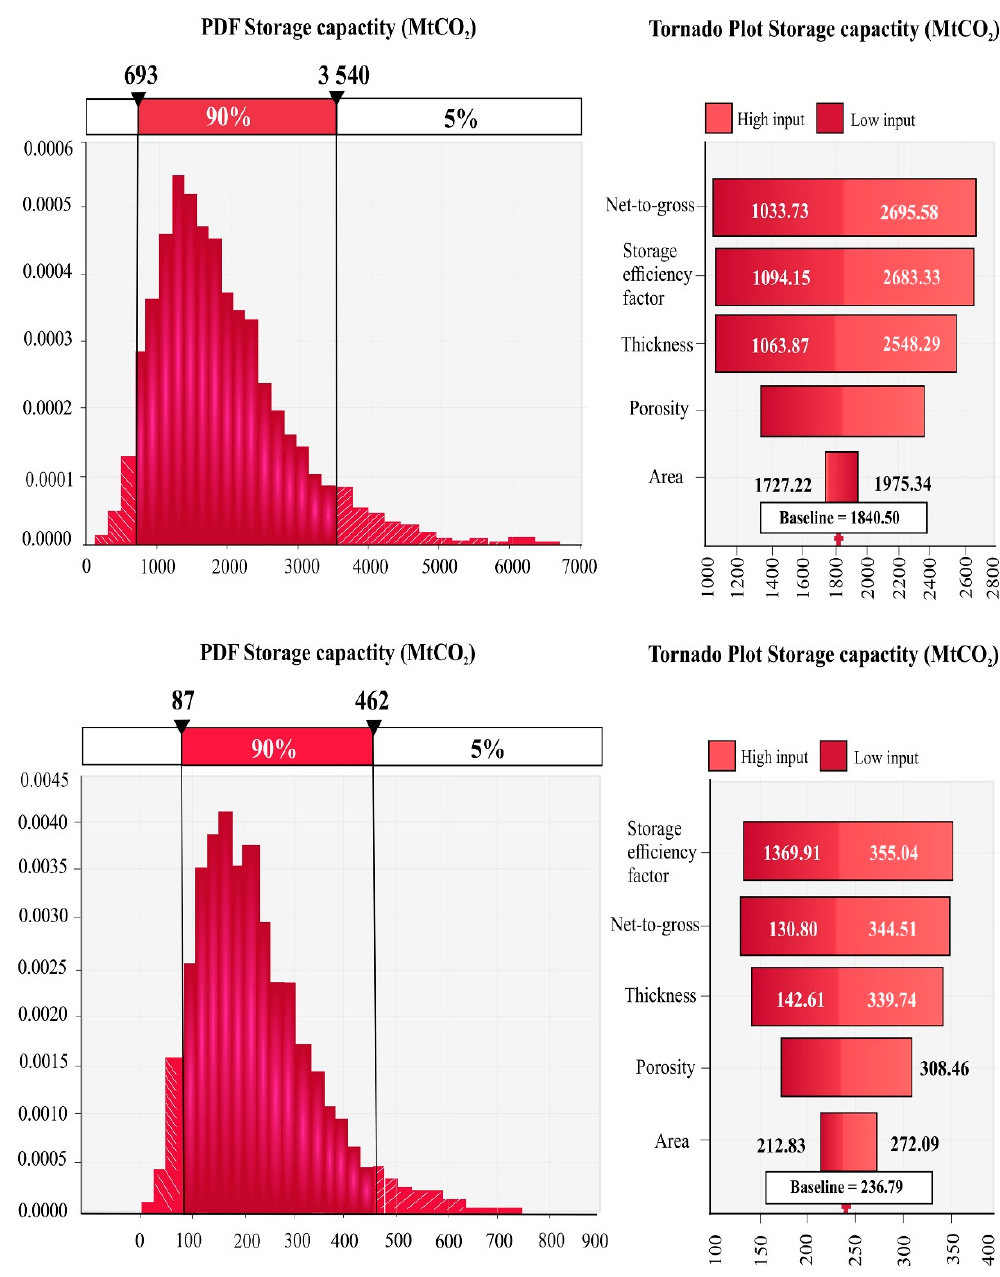
Figure 5. Histograms of storage capacity for the Pentafolos ( top ) and Epatchori Fm ( bottom ), resulting from 5000 Monte Carlo runs of Equation (1) using the probability density distributions (PDF’s) of parameters in Tables 7 and 8, and the corresponding Tornado plots for each geological formation.